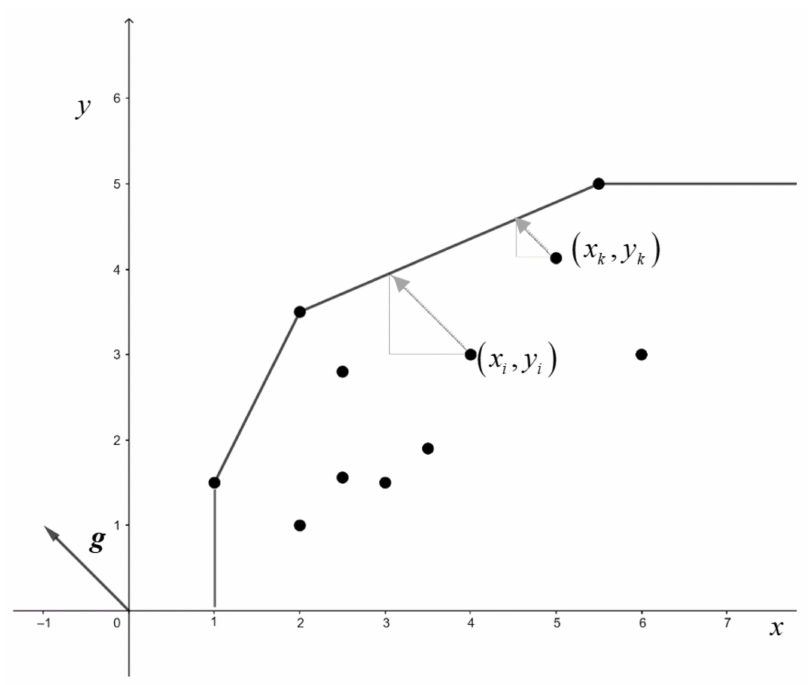
Figure 2. Illustration of the Directional Distance Function in Data Envelopment